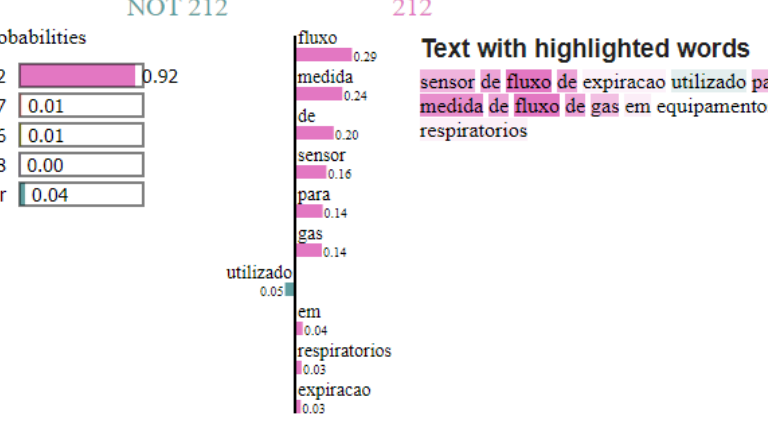
Figure 9. LIME applied to BERT Portuguese classifier.